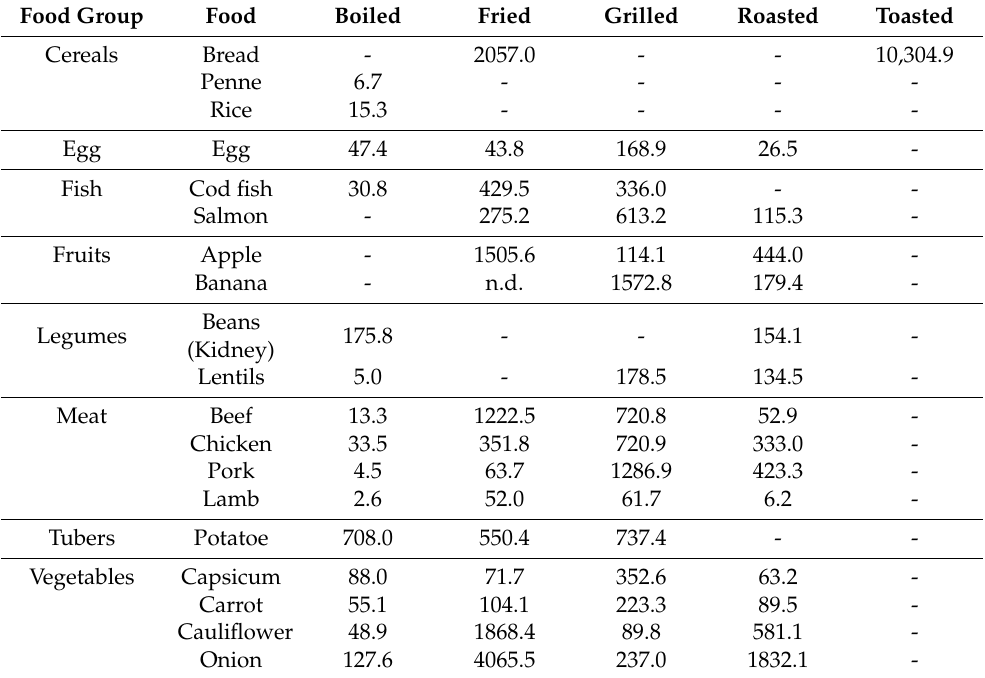
Table 2. HMF values (expressed in µ g HMF/g of food) depending on the cooking method applied to the